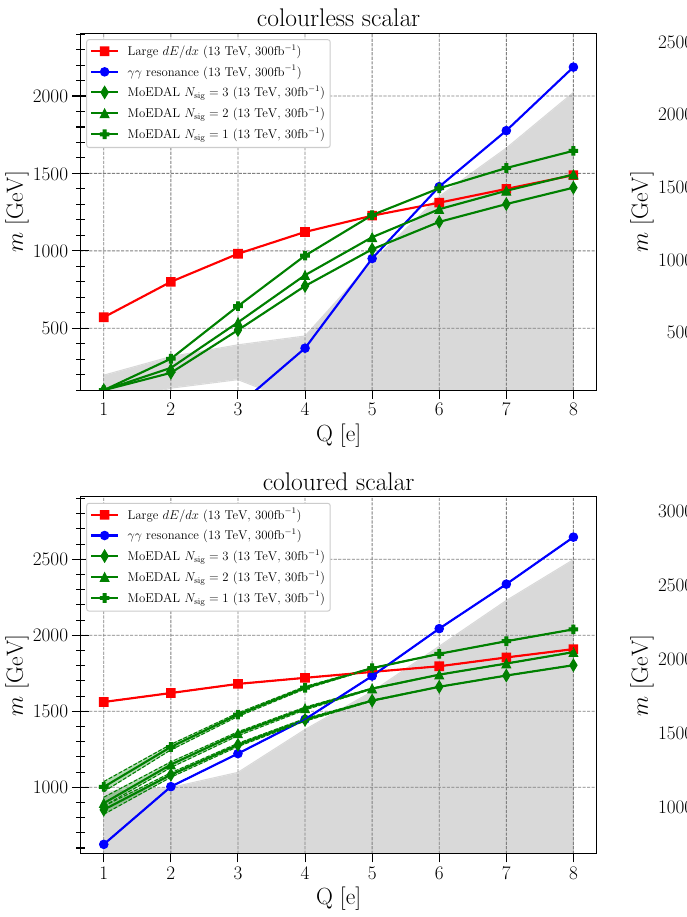
MoEDAL. Green bounds around MoEDAL limits for coloured parti- cles come from uncertainty of the adopted hadronisation model. For open channel ATLAS/CMS searches uncertainty is too small to be vis-